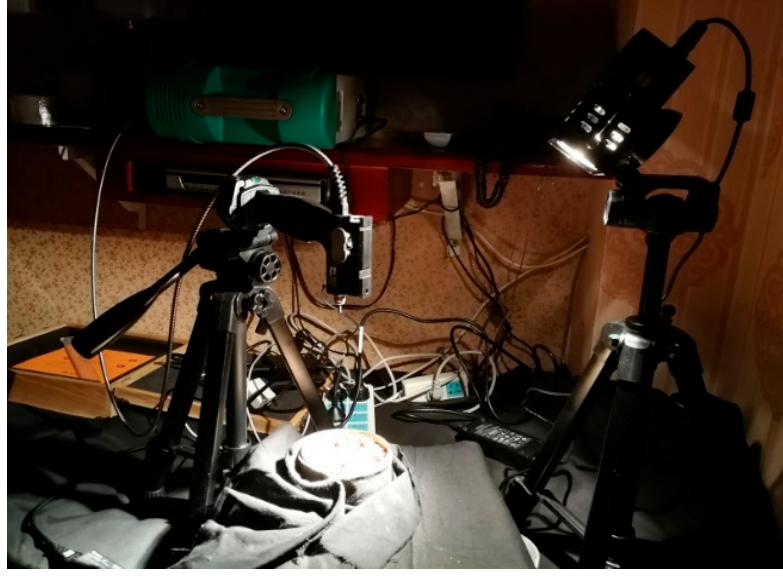
Figure 2. Chart of indoor spectral measurements performed on soil samples.